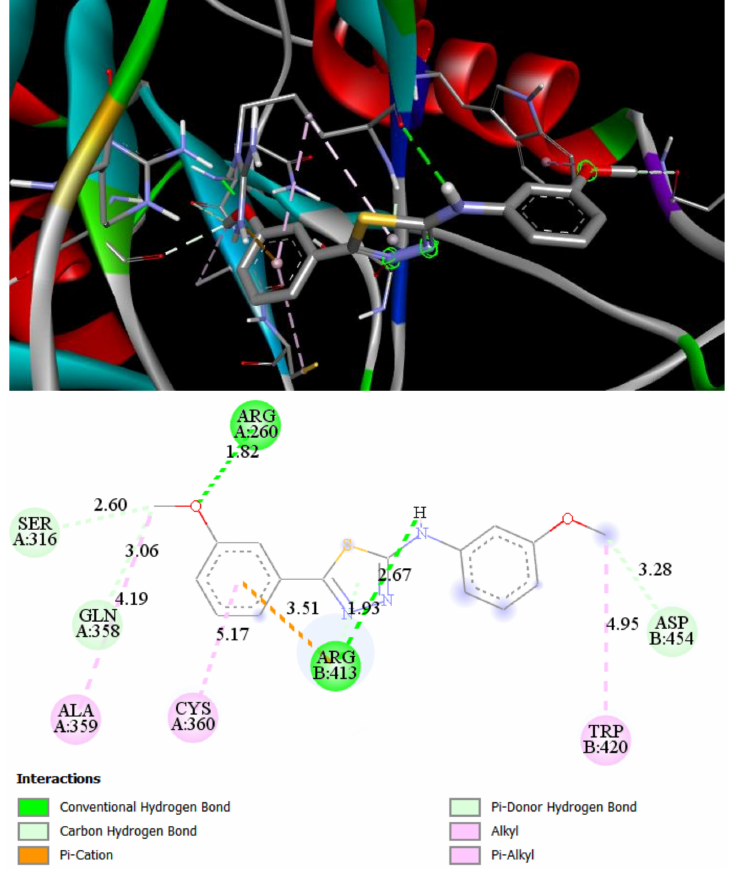
Figure 4. 2D and 3D interaction maps of ST8 with Caspase 8. The best docking score in simulation with Caspase 8 was achieved by ST15 with a value of binding energy − 8.28 kcal/mol and inhibition constant 0.852 µ M. Compound ST15 bound to the active site by its oxygen of 4-NO 2 with GLY318 as a hydrogen bond acceptor with a bond length 2.18 Å. 3-methoxy group forms the hydrogen bond to the TRP420 with a bond length of 2.14 Å. ARG413 forms with both phenyl rings of the molecules by Pi-cation and amide-Pi stacked interactions (Figure 5).